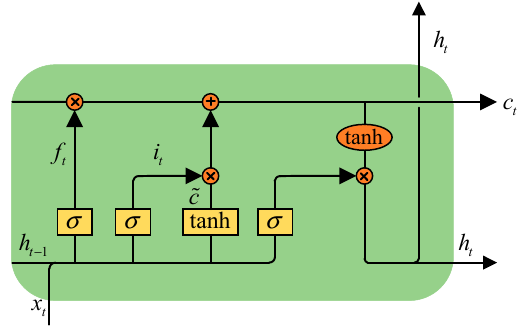
Figure 4. LSTM cell unit.